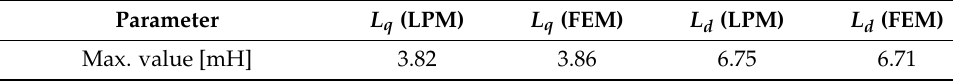
Figure 8. Comparison of inductance curves according to currents using LPM and FEM. Table 5. Comparison of maximum inductance using LPM and FEM.